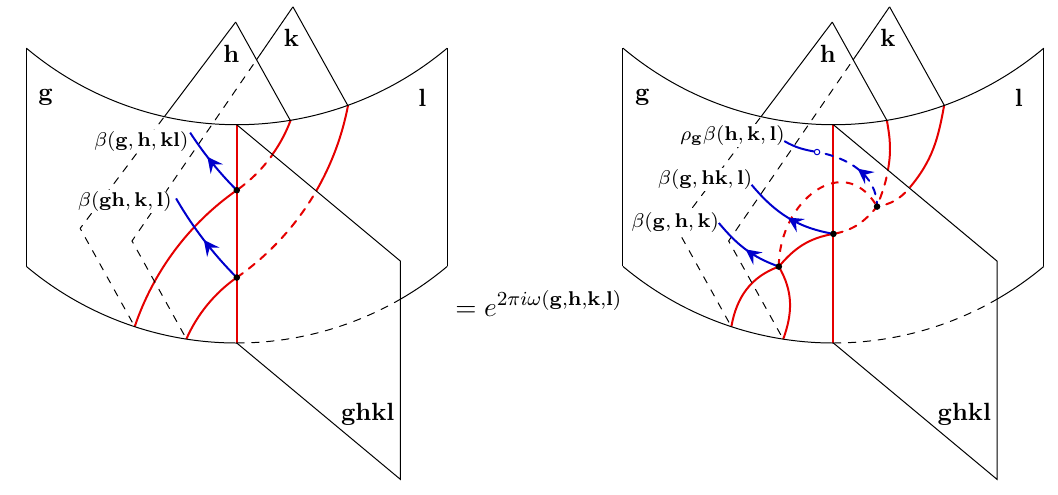
Figure 6 . Following the pentagon identity, the two con(cid:12)gurations of (cid:12)ve joining surfaces can be modi(cid:12)ed one into the other. However, because of the 0-form anomaly, they di(cid:11)er by a phase. The red lines are junctions of three surfaces. Where four surfaces meet (two red lines intersect), a line (in blue) emanates according to the 2-group